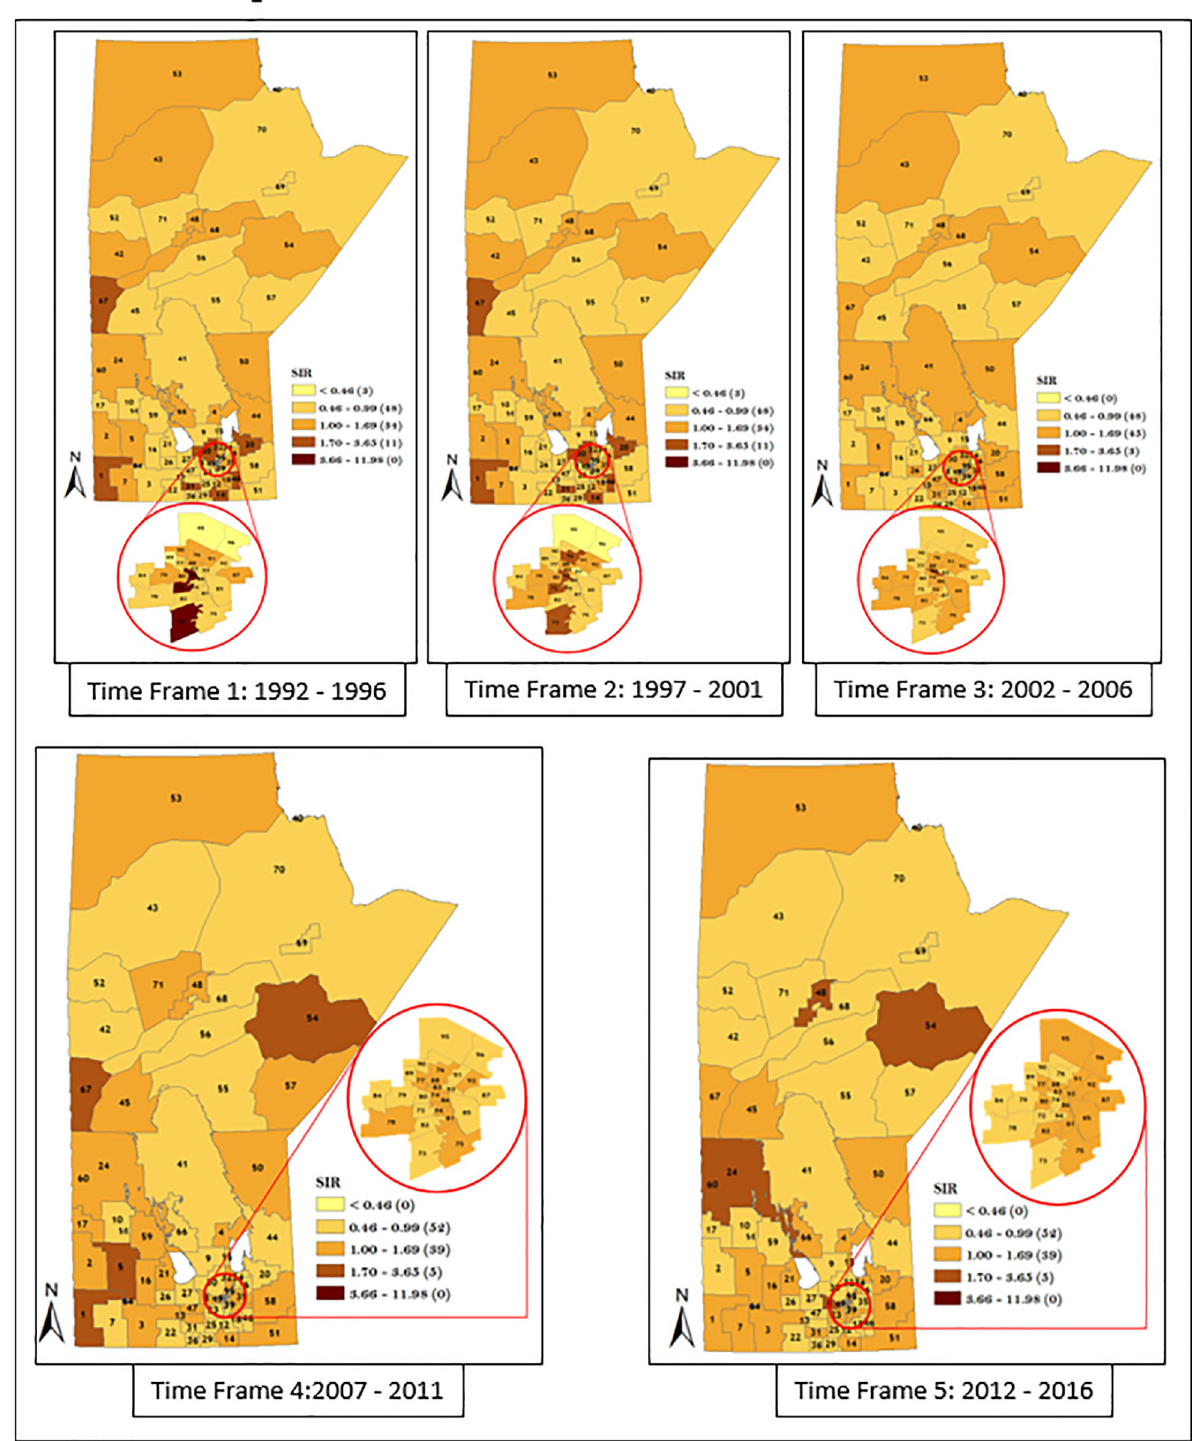
Fig 11. Maps of district-specific risk of overall men GC for the 96 RHADs in Manitoba for five time periods using spatio-temporal Poisson regression model. Numbers in the map are the district labels from 1 to 96. Number of districts in each risk category is shown in parenthesis in the